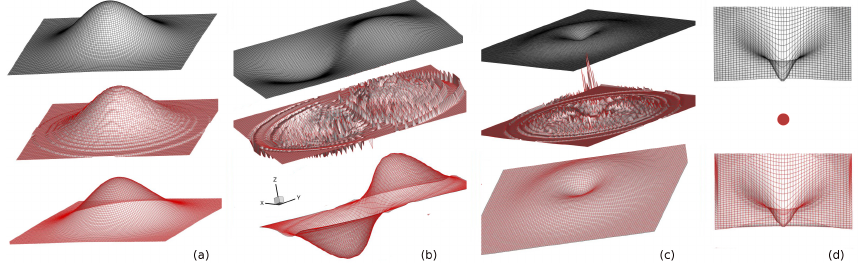
Figure A6. Geometric properties: ( a ) φ = 0 altitude; ( b ) Horizontal component of the (cid:126) n normal vector to the interface; ( c ) Vertical component of the (cid:126) n normal vector to the interface; ( d ) Local curvature κ . ( x , y ) indicates the horizontal interface location of the interface. z corresponds to the studied variable. The top panels show the analytical solution in black. In red, the numerical solutions are plotted without the smoothing technique in the middle of the panels. In red, the numerical solutions are plotted with the smoothing technique in the bottom of the panels. The poor numerical curvature without smoothing is not presented (bell